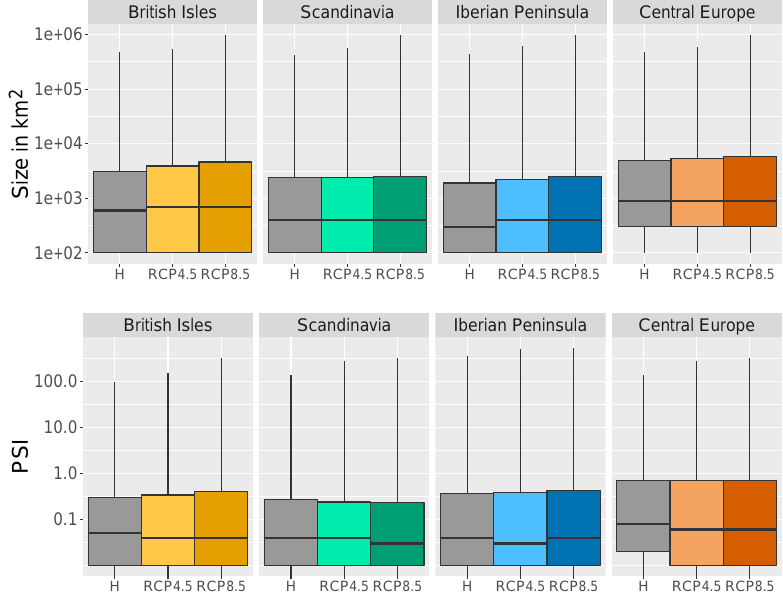
Figure 8. Size and strength distribution of detected daily and multi-day heavy precipitation events in four different European regions (British Isles, Iberian Peninsula, Scandinavia and Central Europe). The ensemble mean for the historical simulation (grey), the RCP4.5 (light colour) and the RCP8.5 (bright colour) scenario simulation for the period 2071–2100 are shown. The box plots show the median, 25th and 75th percentile and the whiskers span the range from the smallest to the largest